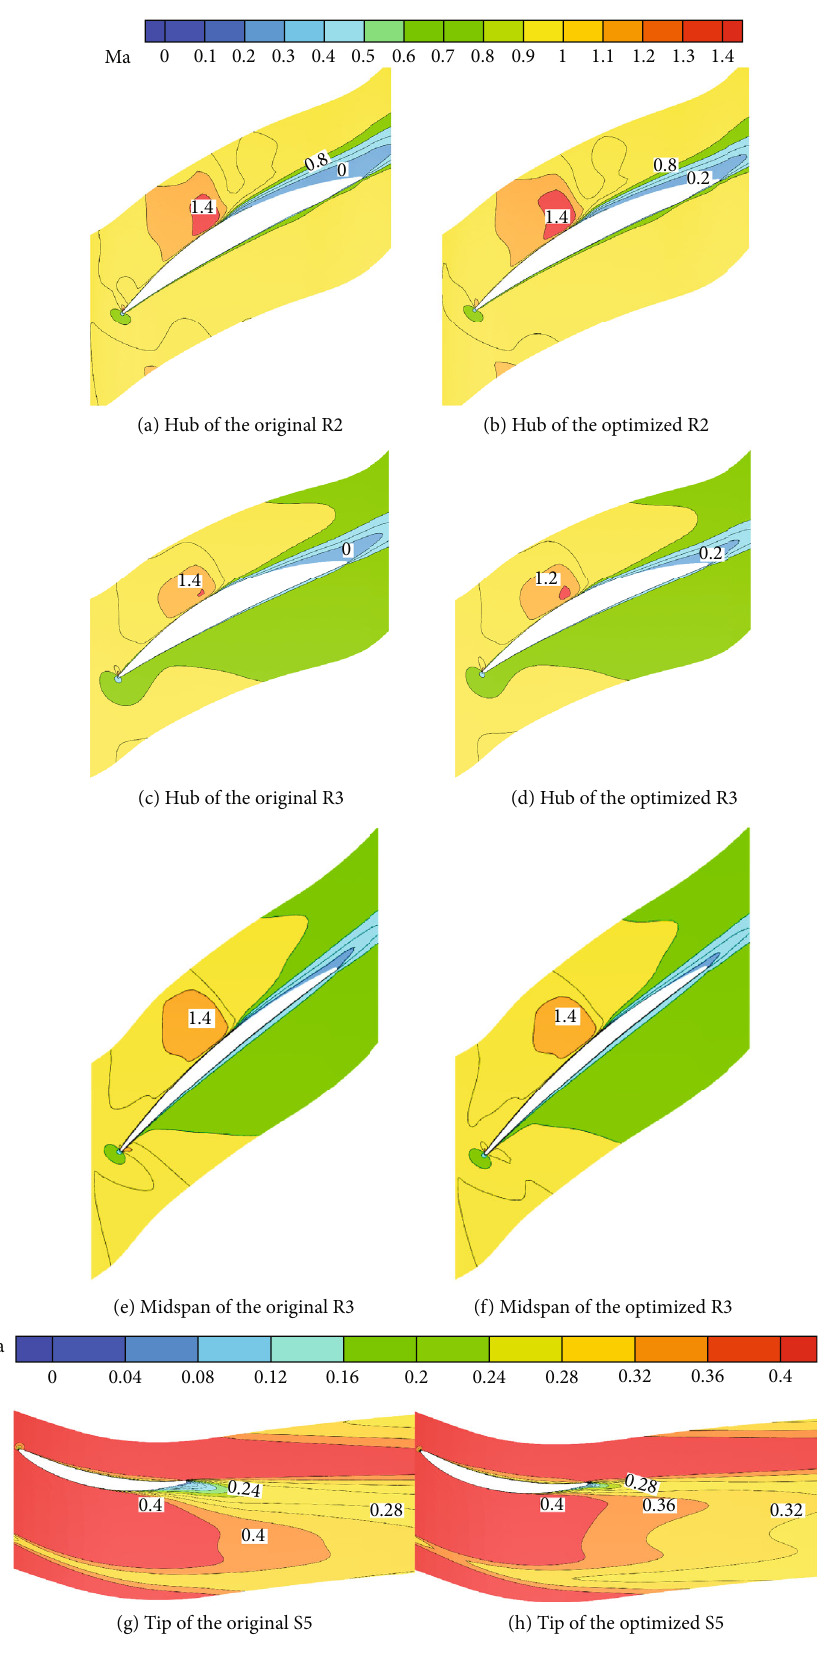
Figure 15: Comparison of the relative Mach number at the hub of R2, R3 and at the tip of S5 before and after